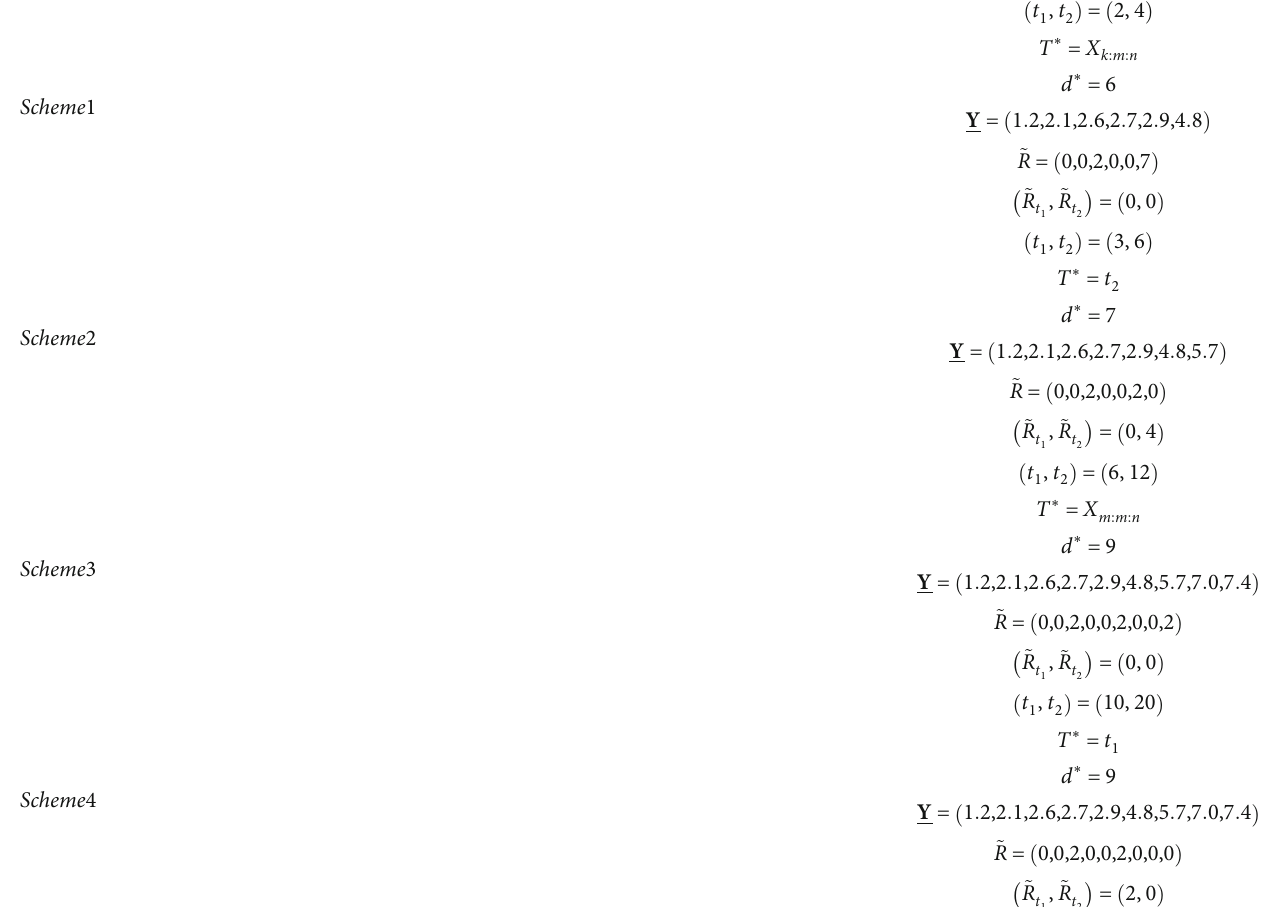
Table 6: The di ff erent Type-II uni fi ed HPCS with ð m , k Þ = ð 9, 6 Þ and di ff erent choices of T